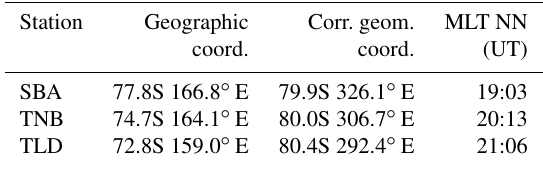
Table 1. Geographic coordinates, IGRF08 corrected geomagnetic coordinates and time in UT of the geomagnetic local noon (NN) for the three stations.